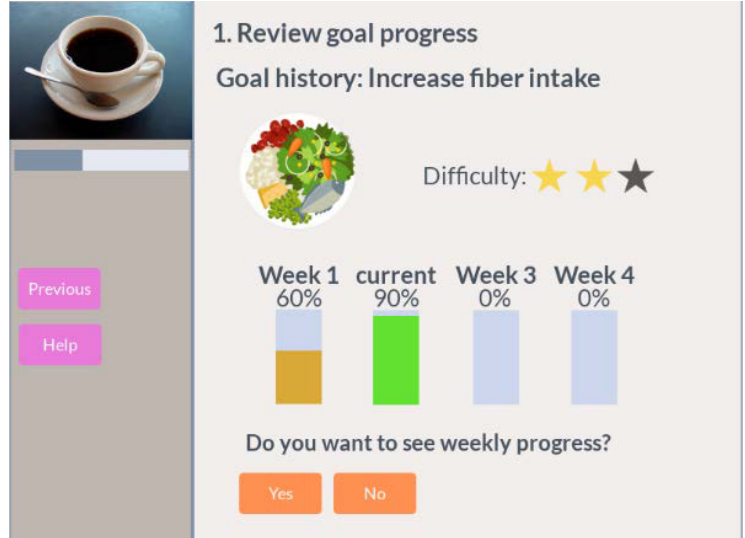
Figure 10. Coffee review progress, overall performance.